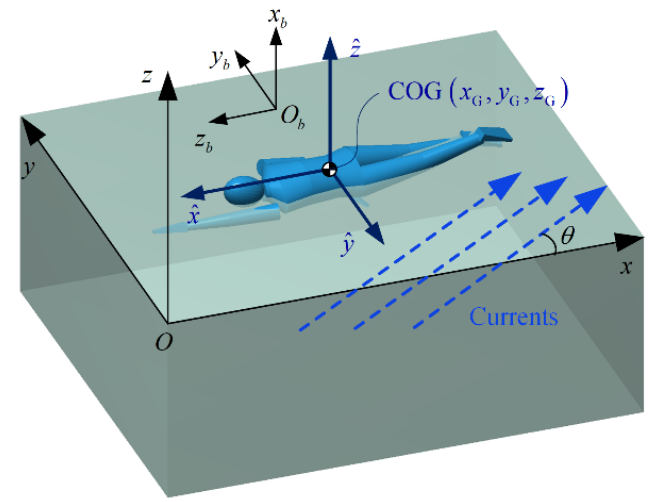
Figure 2. Dynamic model of human swimming. Three coordinate systems are established, the global coordinate system o xyz − , the human body coordinate system at the section center of the middle trunk root), and the COG-principle-axes coordinate ˆˆˆ G xyz − . The